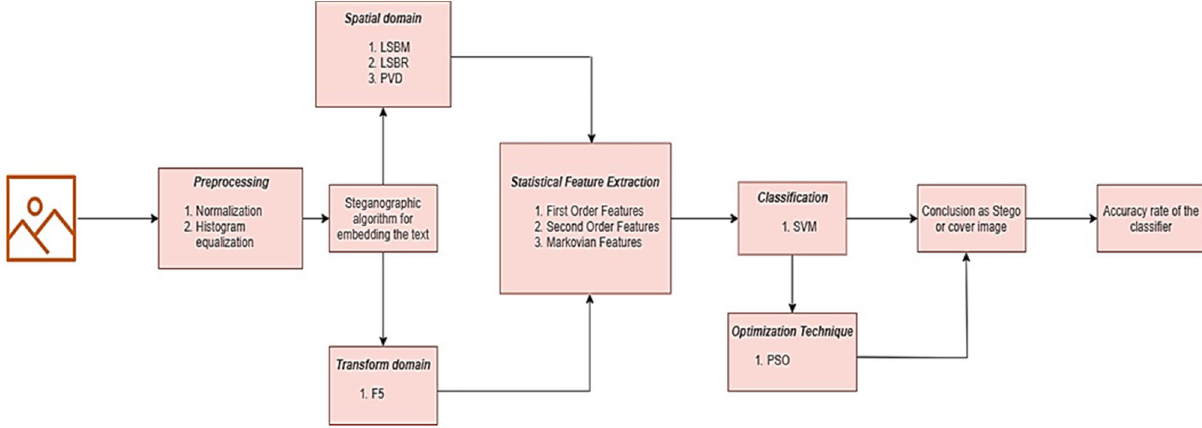
Figure 2. Flowchart explaining the methodology used in the work.